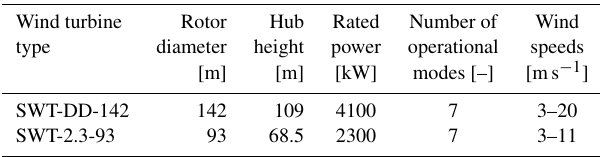
Table 1. Specifications of the two wind turbine